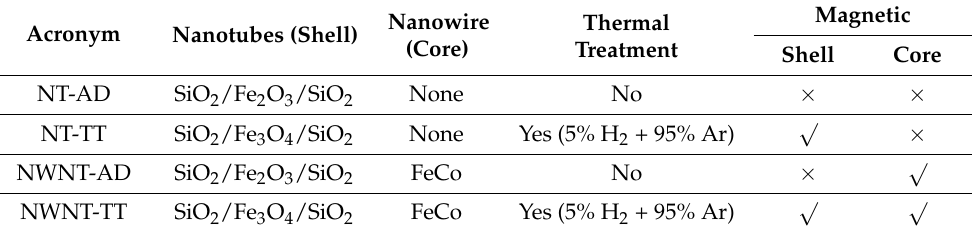
Table 1. Designations used for the different samples’ terminology employed during this